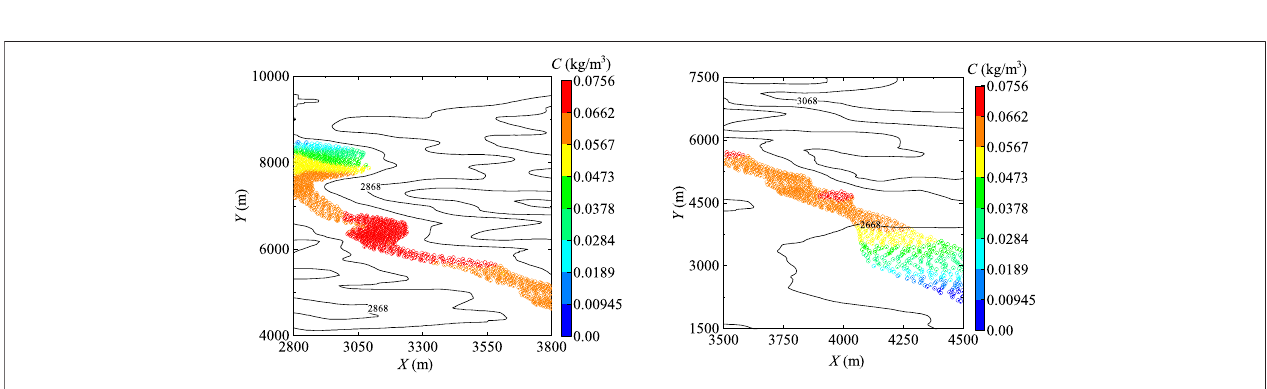
FIGURE 10 | Peak contaminant concentration